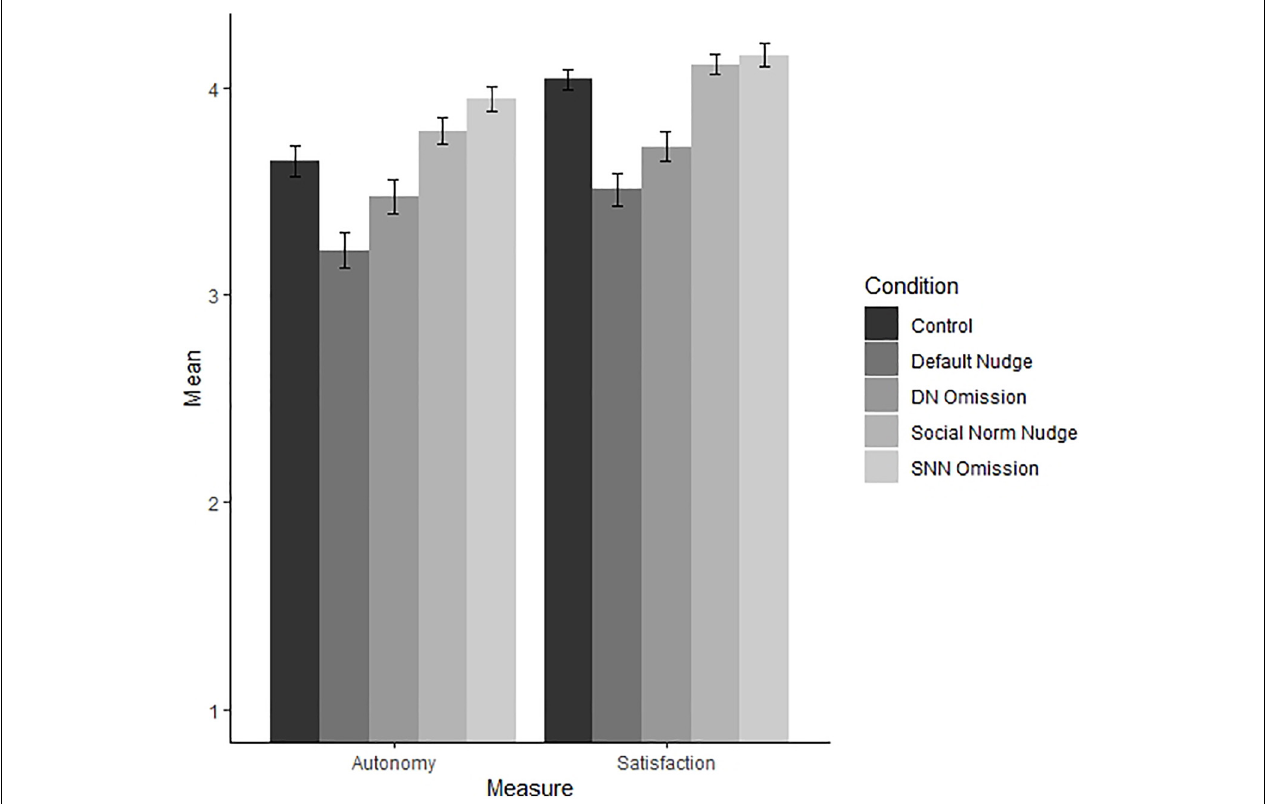
FIGURE 3 | Autonomy, competence, and satisfaction per condition (Study